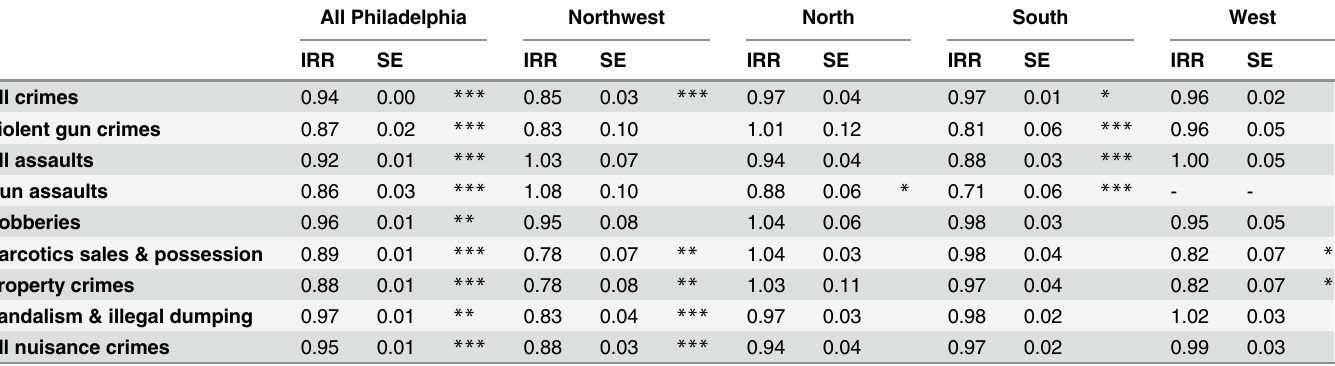
Tests for spillover effect found a reducing effect size with increasing distance away from buildings after treatment. Within one-eighth mile of building treatment sites, models showed a non-significant 1% decrease in total crimes. Between one-eighth and one-quarter miles from building treatment sites, there was a non-significant 1% decrease and between one-quarter and one-half miles from building treatment sites there was a 1% decrease in total crimes. Table 4. Adjusted Difference-in-Differences Estimates of Renovation Permit on Census-Tract Level Crime Outcomes, by City Section, Philadel- phia, PA, January 2010 – April 2013 1 . All